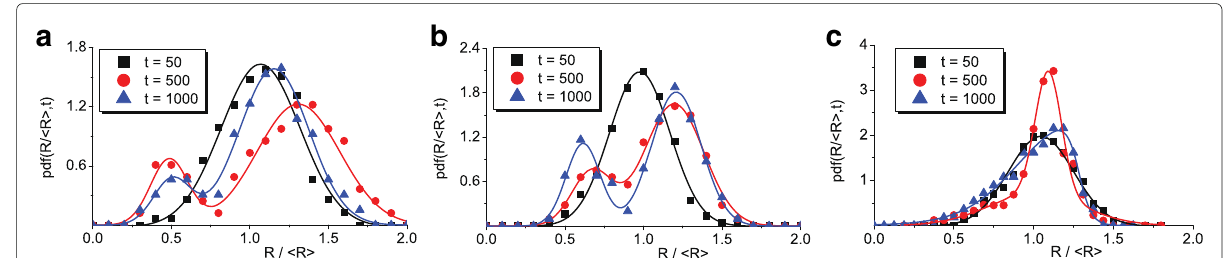
Fig. 4 Evolution of adsorbate islands distribution function over re-normalized sizes on a half-height of a growing surface at different values of anisotropy strength: a u = 3, b u = 4, and c u =